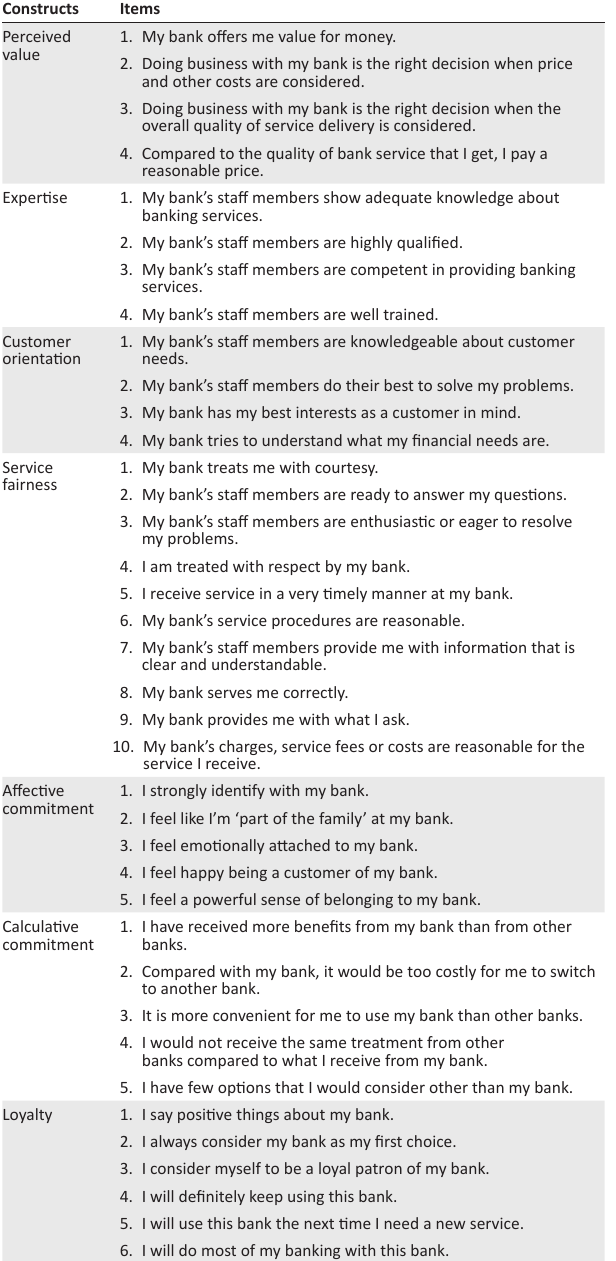
TABLE 1: Constructs and items.